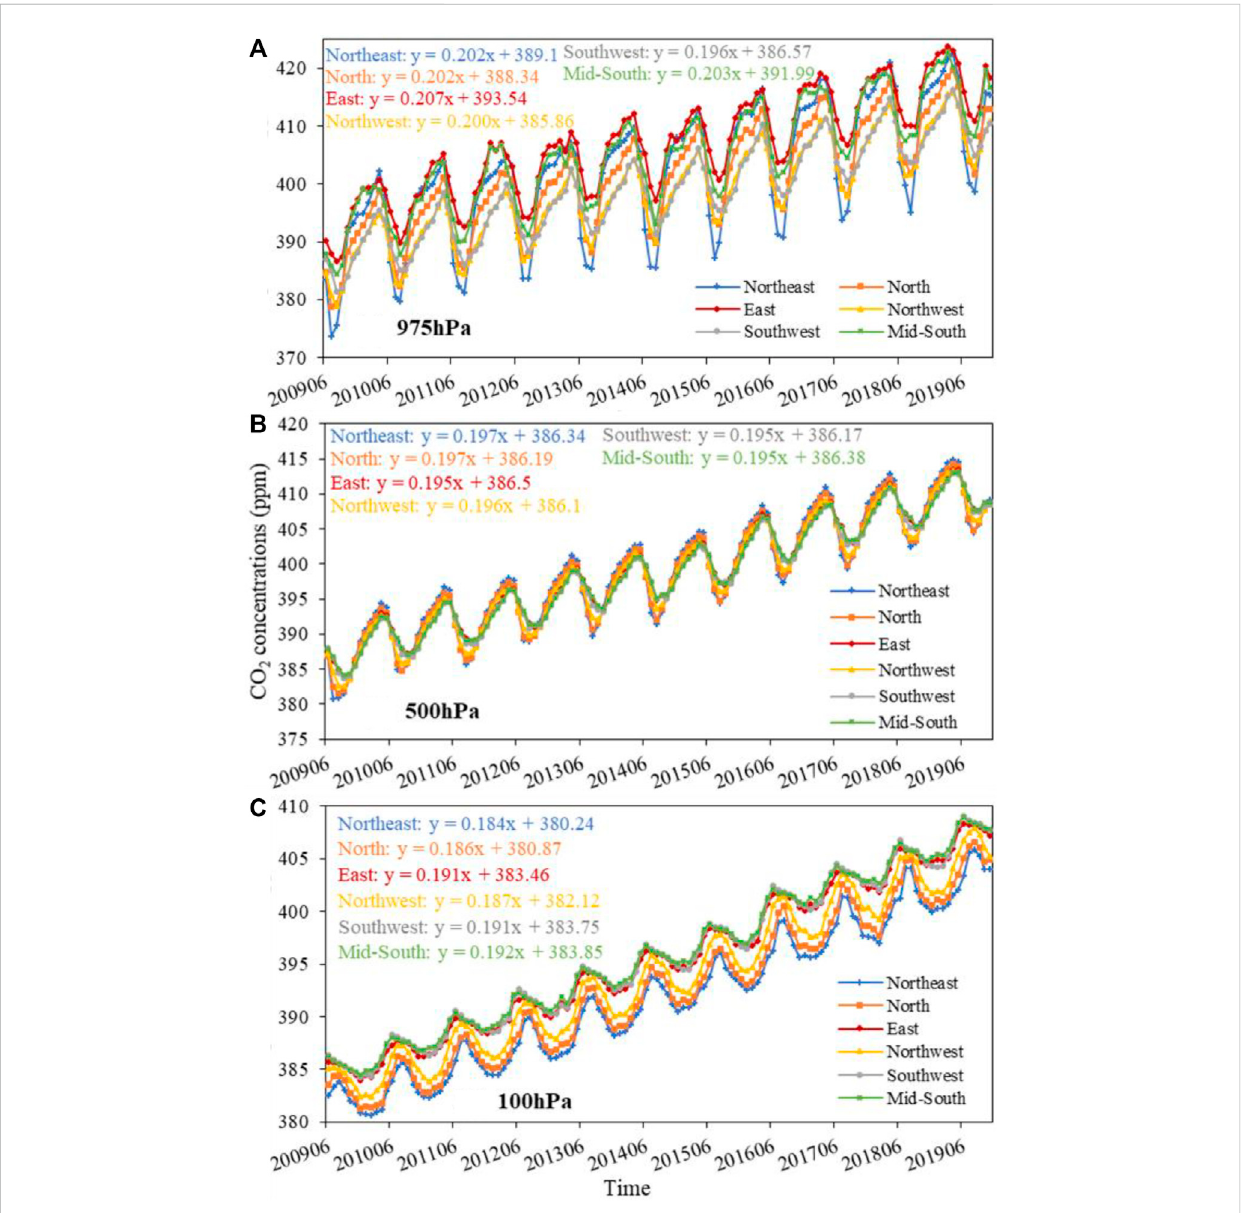
FIGURE 4 Interannual changes of CO 2 concentrations during the period 2009 –